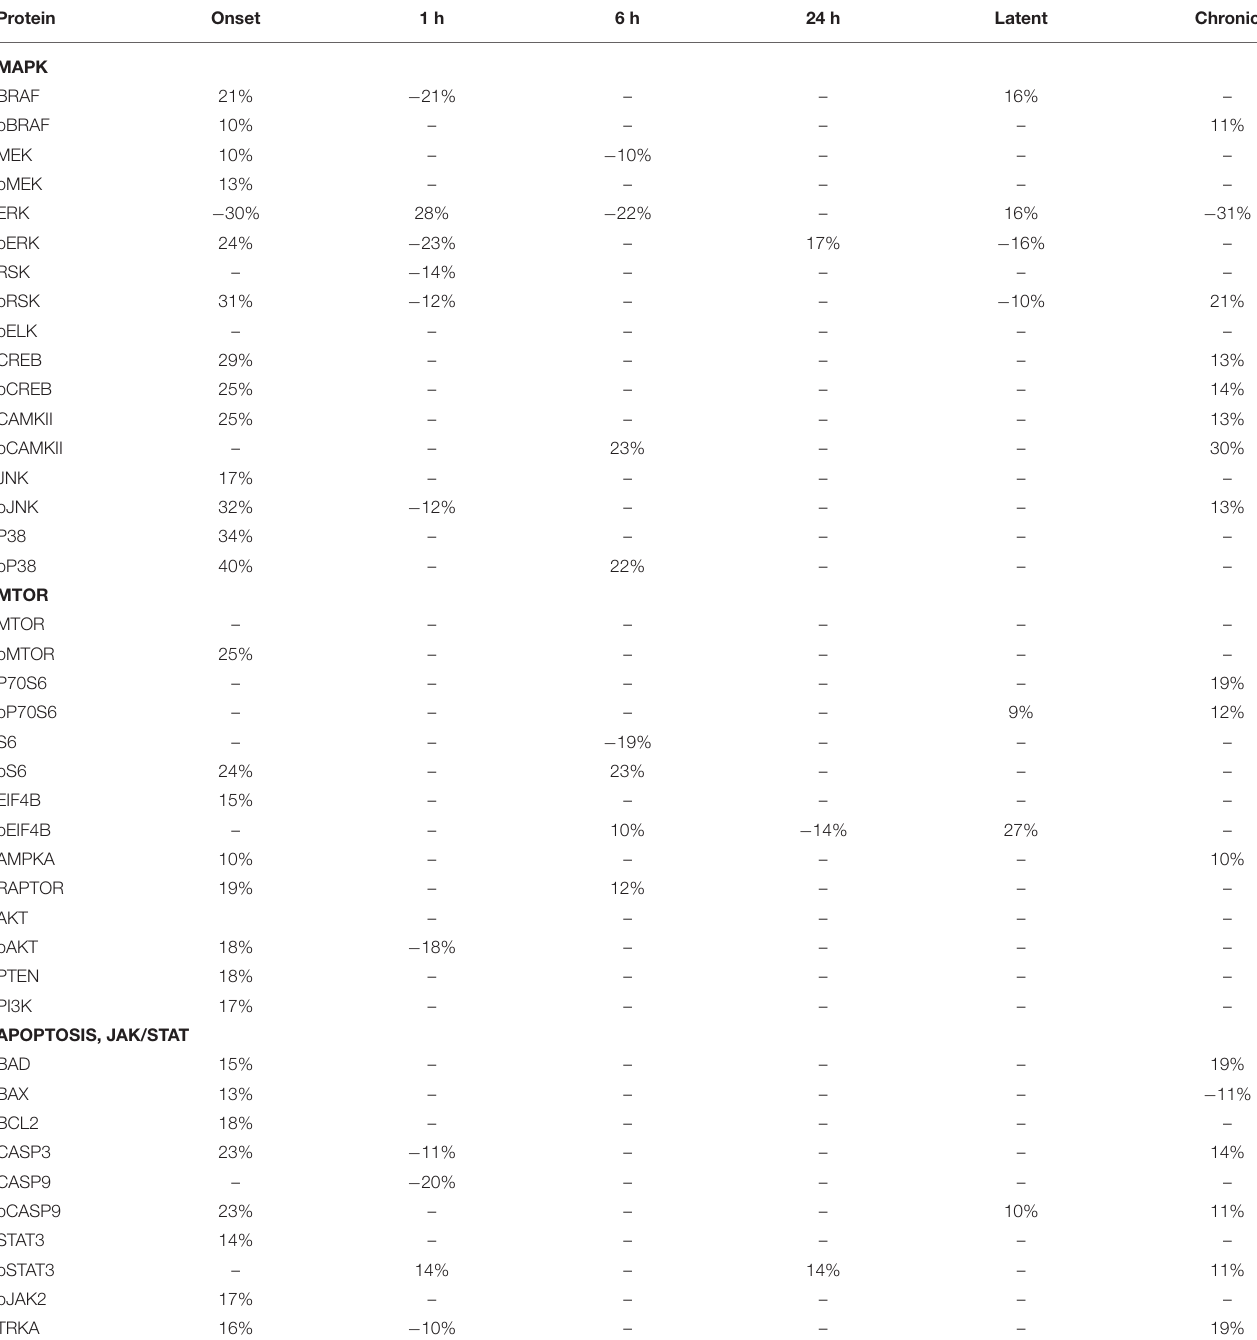
TABLE 4 | Protein changes in cerebellum, MAPK, MTOR, JAK/STAT, and apoptosis pathway components (pilocarpine vs. saline at corresponding time points). Protein